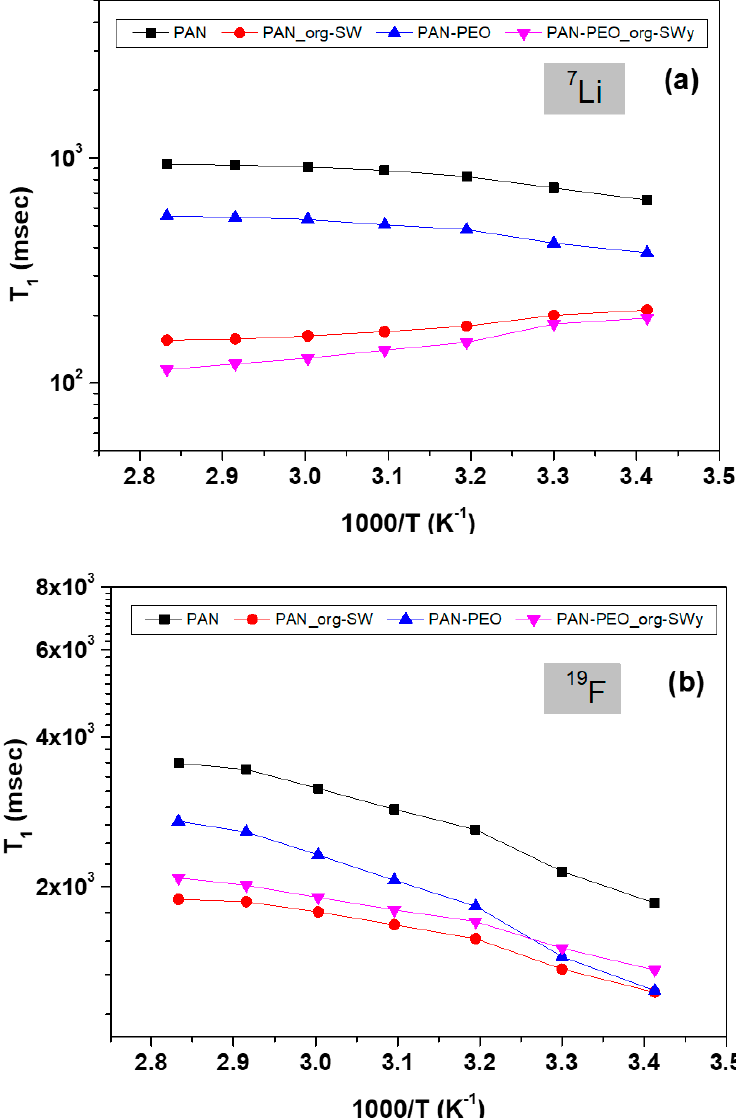
Figure 8. Arrhenius plot of 7 Li ( a ) and 19 F ( b ) spin-lattice relaxation time from 20 °C up to 80 °C.